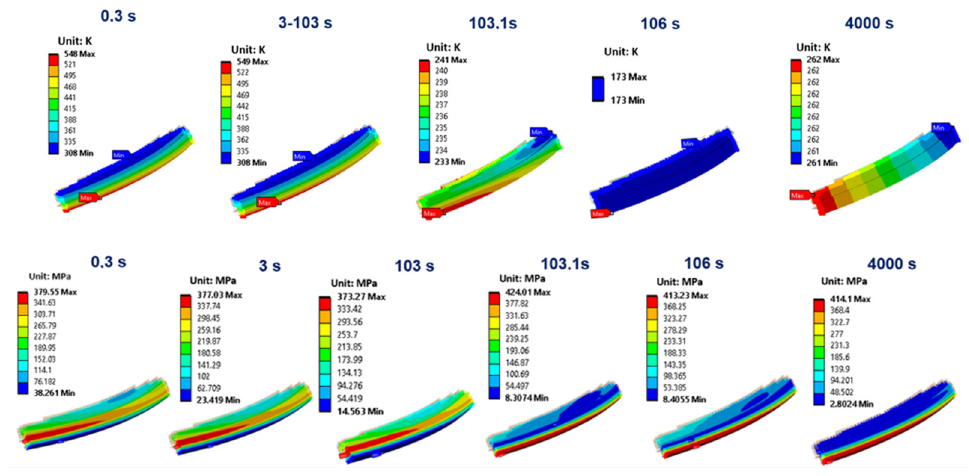
Figure 11. Temperature and von Mises contour plots at the most significant time instants of the first